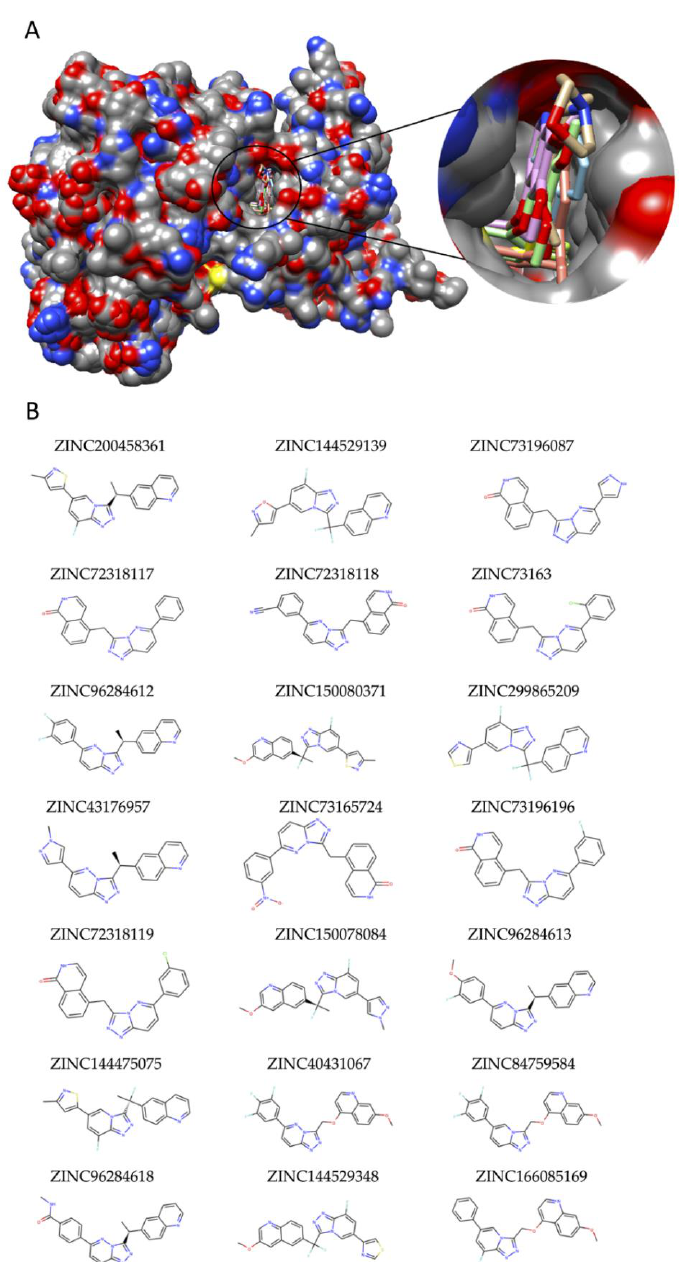
Figure 4. Virtual screening to identify potential hit drug candidates for pRCC. ( A ) Superposition of X-ray crystal structures of MET retrieved from RCSB for the validation of docking protocol. ( B ) 2D structures of ZINC molecules that showed high binding affinities to MET protein in virtual